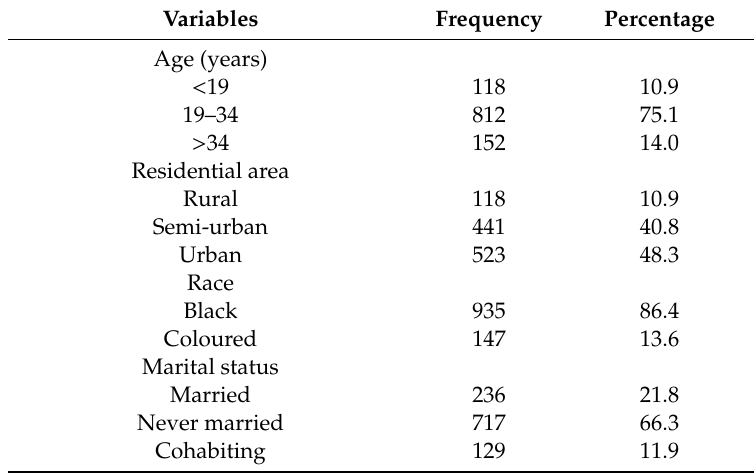
Table 1. Socio-demographic, obstetrics and lifestyle characteristics of